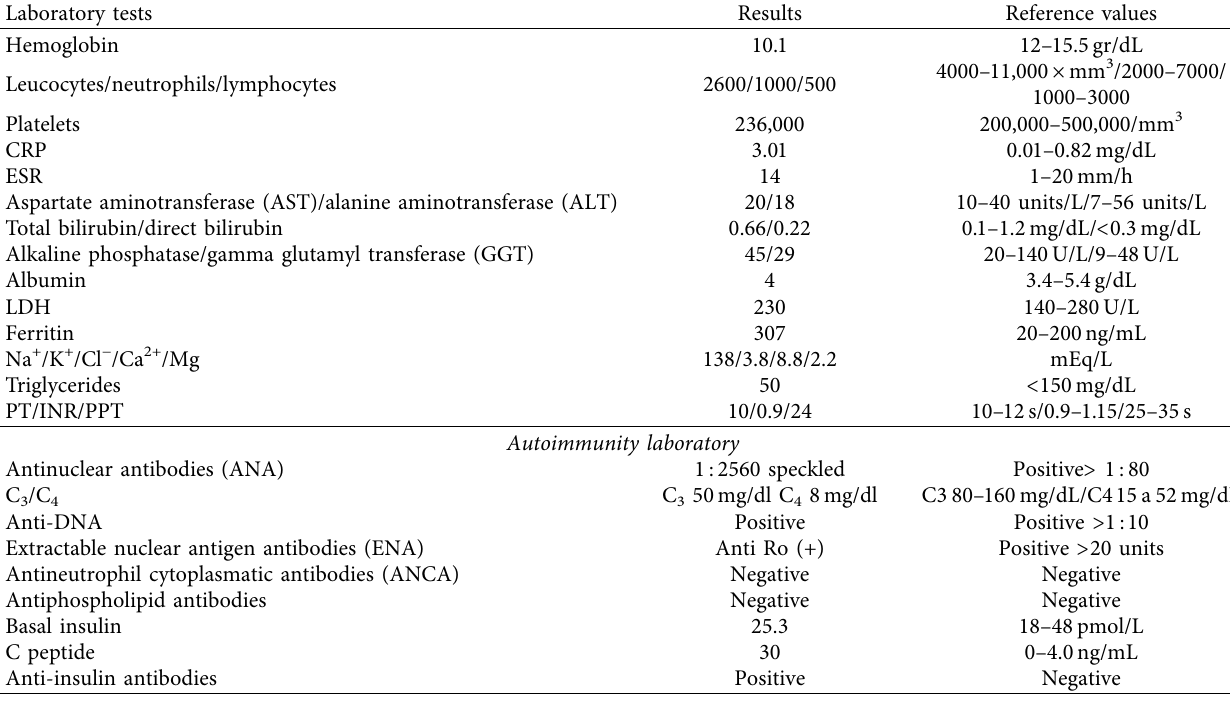
Table 1: Laboratory results during patient’s hospital stay.